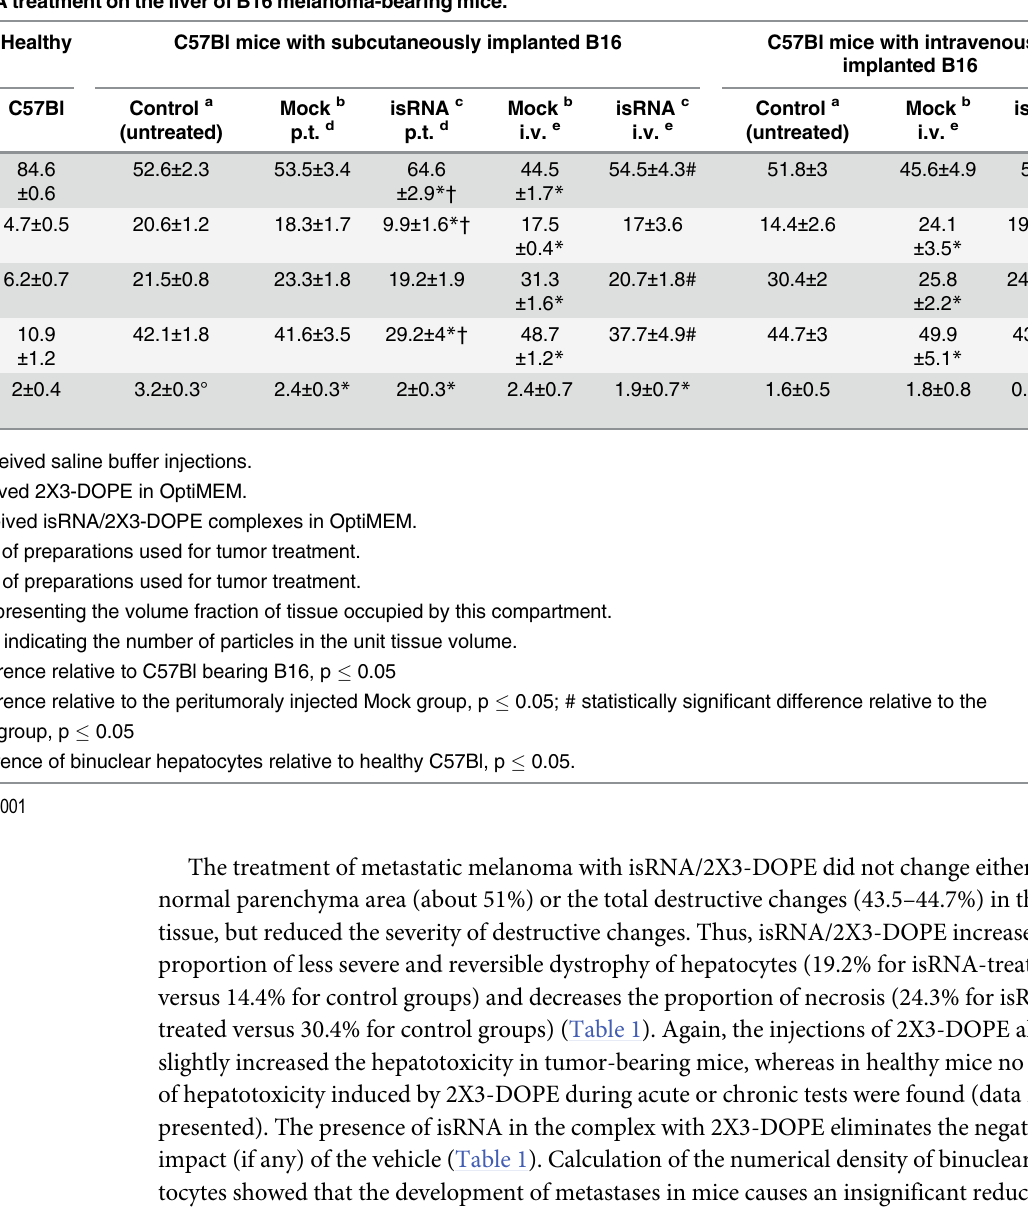
Table 1. The effect of isRNA treatment on the liver of B16 melanoma-bearing